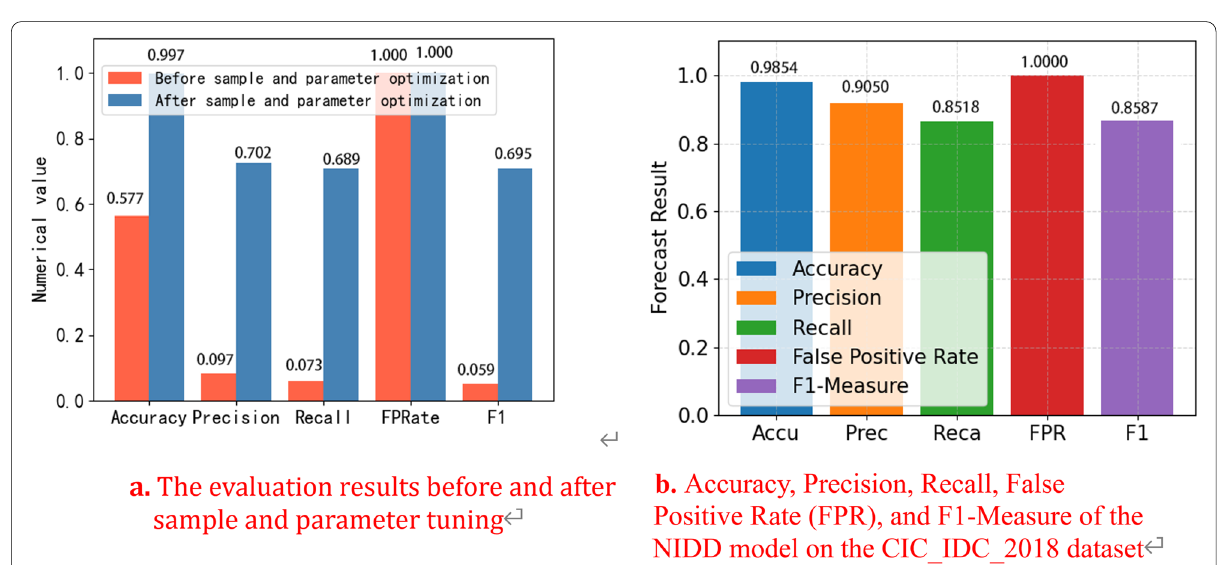
Fig. 10 Comparison of samples with parameters before and after adjustment and validation on the CIC_IDC_2018